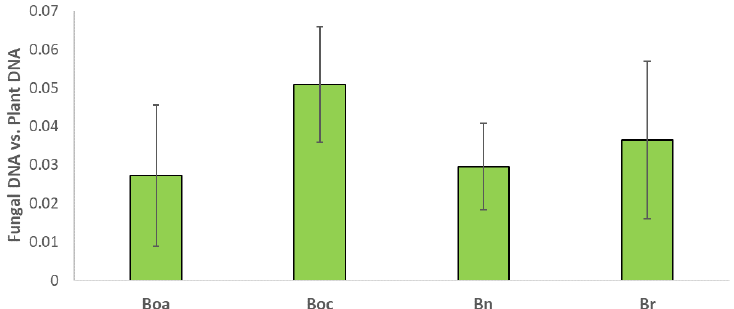
Figure 4. Measurements of Brassica -root colonization by Trichoderma by qPCR in kale (Boa), cabbage (Boc), leafy rape (Bn) and leafy turnip (Br). Values are the proportion of fungal DNA vs. plant DNA means of three root pools (three plants each one) with the corresponding standard deviations. One-way analysis of variance (ANOVA) was performed, followed by the Tukey’s test. No significant differences ( p < 0.05) were found.